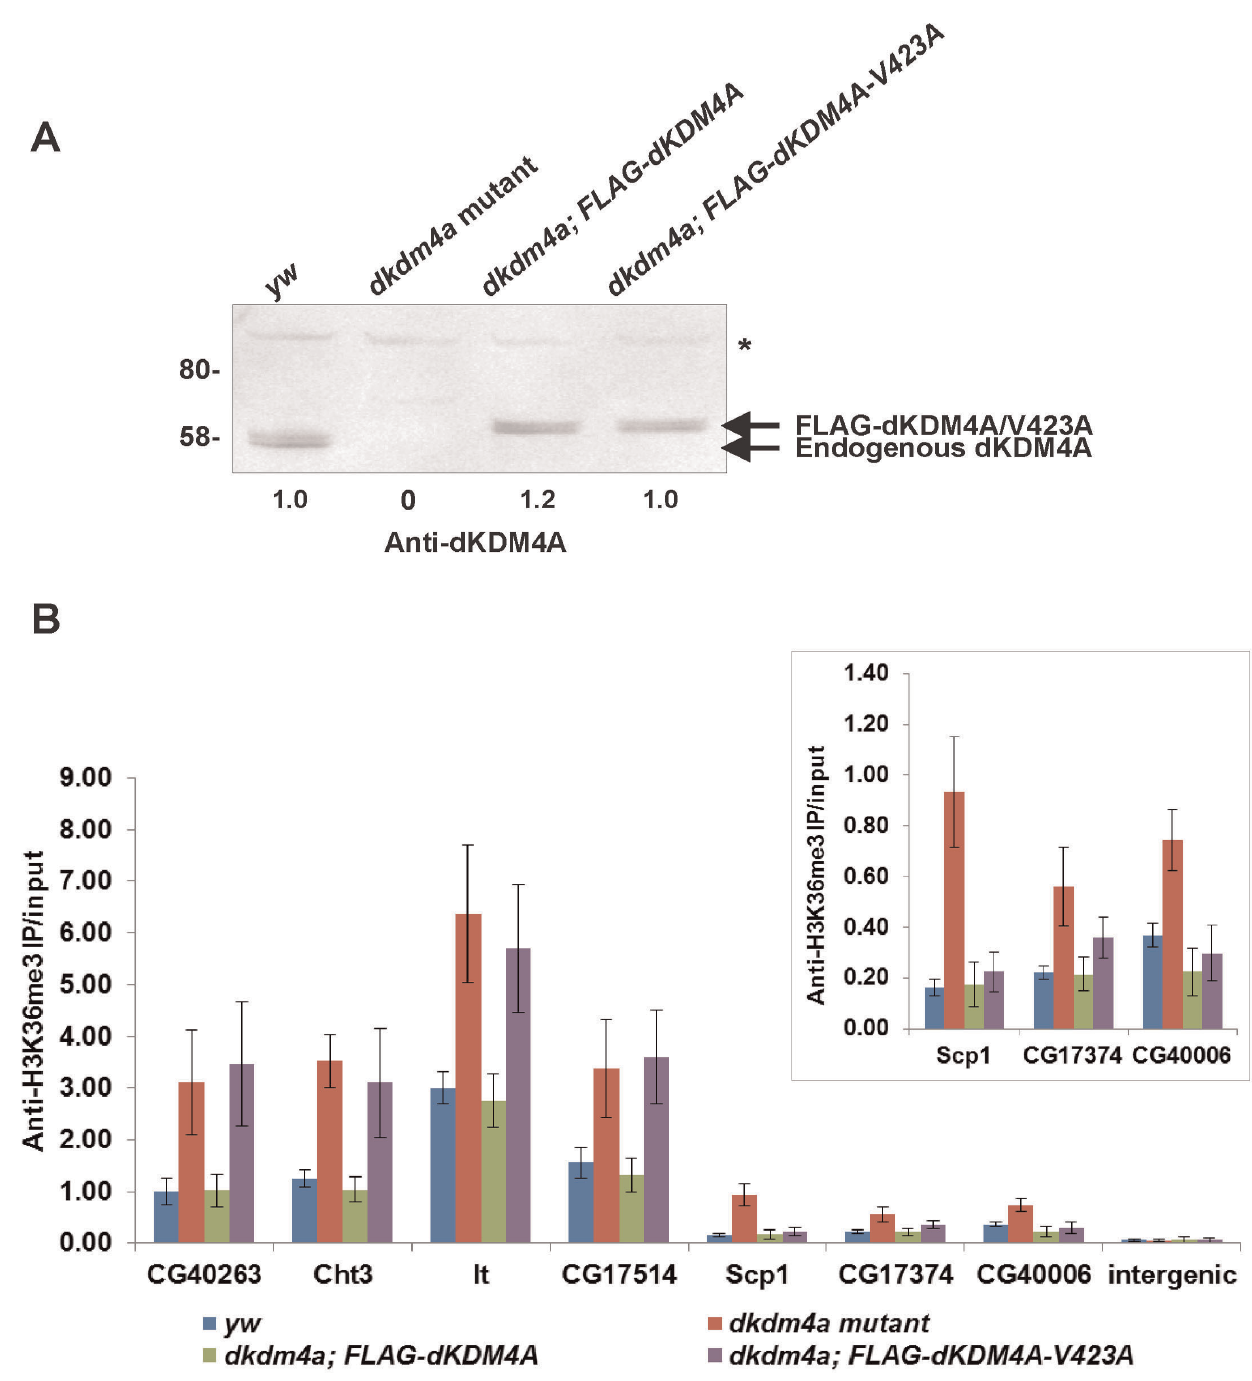
Figure 4. dKDM4A-mediated H3K36me3 demethylation requires HP1a binding at a subset of heterochromatic genes. (A) The expression level of endogenous dKDM4A and FLAG-tagged dKDM4A or dKDM4A-V423A. Nuclear extracts from embryos of yw , dkdm4a mutants and mutants rescued by FLAG-dKDM4A were analyzed by western blot. The doublet band is likely to represent two isoforms of dKDM4A. Asterisk indicates non-specific signal. Quantitation of the signal intensity is shown below the blot. (B) The enrichment of H3K36me3 at HP1a-bound heterochromatic genes was observed by ChIP-qPCR. Genes with lower H3K36me3 levels ( Scp1, CG17374 and CG40006 ) are also shown in a separate panel. The primer set amplifying an intergenic region at chromosome 2 L was used as a negative control. The error bars represent standard deviation from 3 biological repeats. doi:10.1371/journal.pone.0039758.g004 CG40263 , Cht3 , lt and CG17514 (Figure 4B). Thus, based on our H3K36me3 levels that is independent of dKDM4A binding to HP1a at Sarcoplasmic calcium-binding protein 1 ( Scp1) , CG17374 and results, binding to HP1a is required for demethylation of CG40006 , where the level of H3K36me3 is lower than that at H3K36me3 by dKDM4A at a subset of heterochromatic genes.